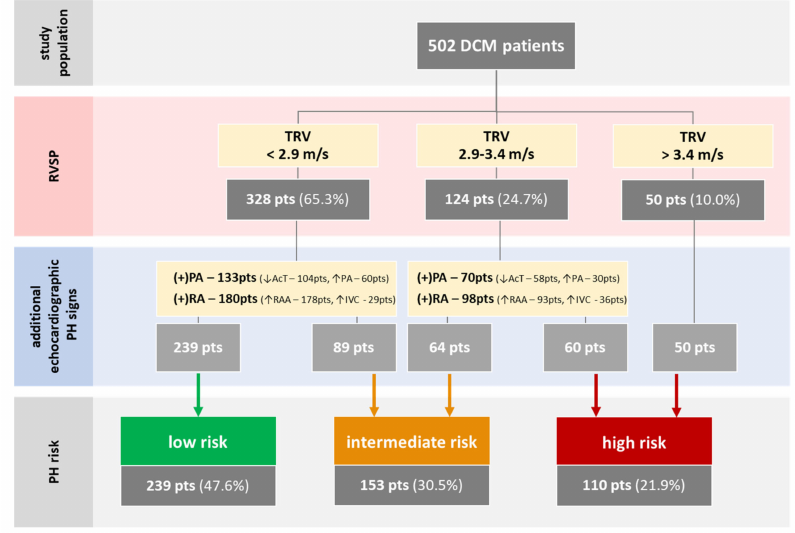
Figure 2. The division of the study population into three groups according to the PH-risk assessment based on Figure 1. Patients were divided according to TRV and, then in the absence of other PH signs, placed into a lower PH-risk group and in the presence of both ( + )PA and ( + )RA signs, to a higher PH-risk group. Designations: “ ↓ ”—low, “ ↑ ”—high / enlarged, “( + )”—a positive sign of either PA or RA. Abbreviations: DCM—dilated cardiomyopathy, pts—patients, TRV—peak tricuspid regurgitation velocity, PH—pulmonary hypertension, PA—pulmonary artery, AcT—acceleration